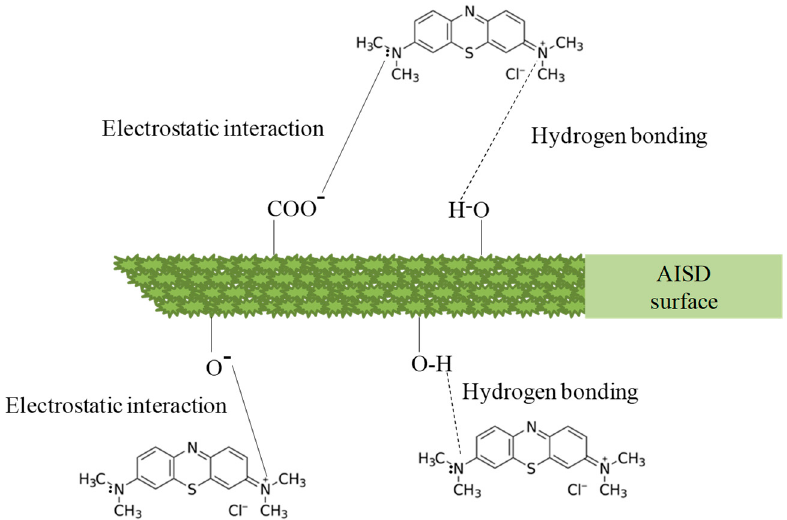
Figure 8. Proposed mechanism of adsorption of CV dye on AISD.